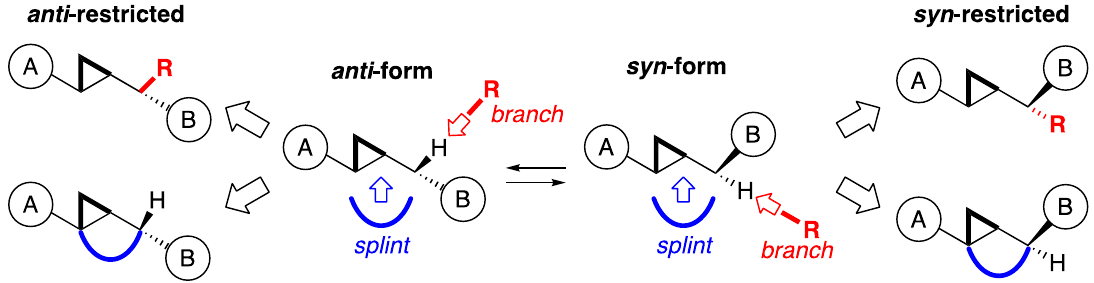
Figure 3. The two strategies to conformationally restrict the cyclopropane-based analogues to the anti - or syn -form by the introduction of a “branch” substituent inducing the cyclopropylic strain or a “splint” moiety forming the bicyclo structure.